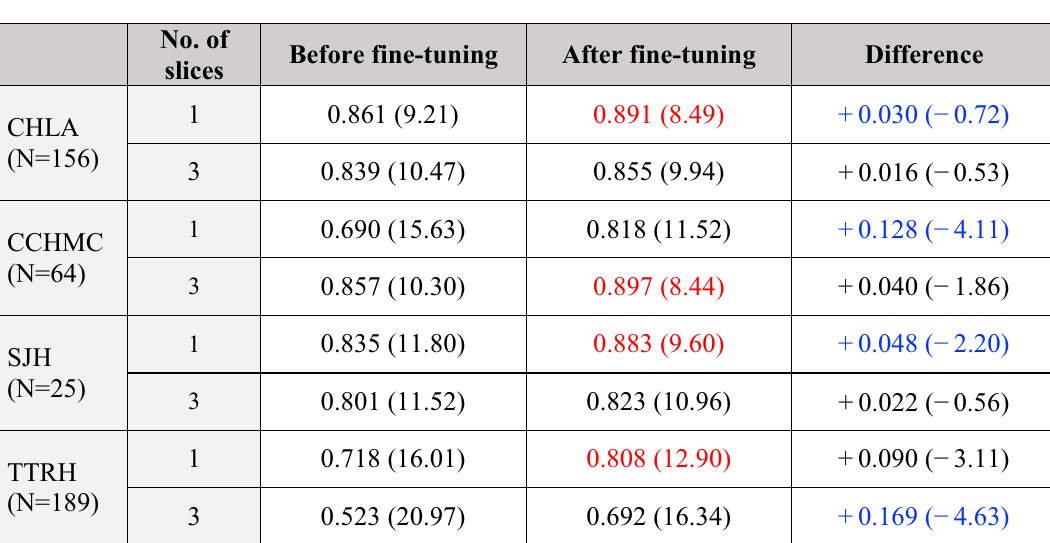
Table 2. External validation of attention-guided, multi-plane, 1-slice and 3-slice models. R 2 scores and corresponding MAE (days) are shown before and after fine-tuning on data from other institutions. This external validation uses the highest-scoring model architecture (attention-guided multi-plane) based on the Stanford dataset. 20% of each external dataset was used for fine-tuning and the other 80% for testing model performance and generalizability. The largest improvements in R 2 and MAE are shown in blue for each dataset. The most generalizable architecture for each dataset is in